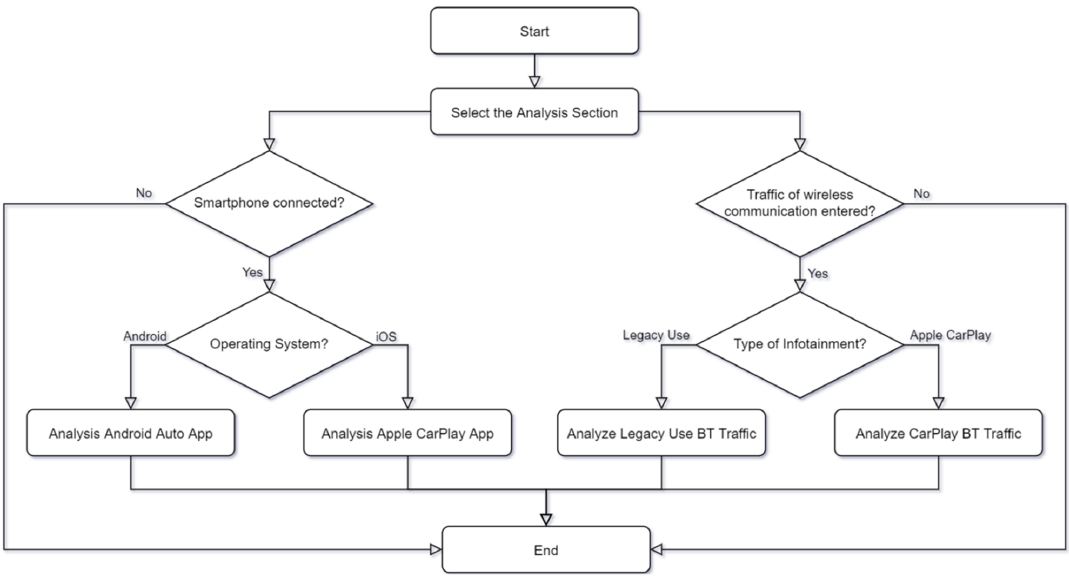
Figure 9. Flowchart for analyzing BT packets between a mobile device and a vehicle.